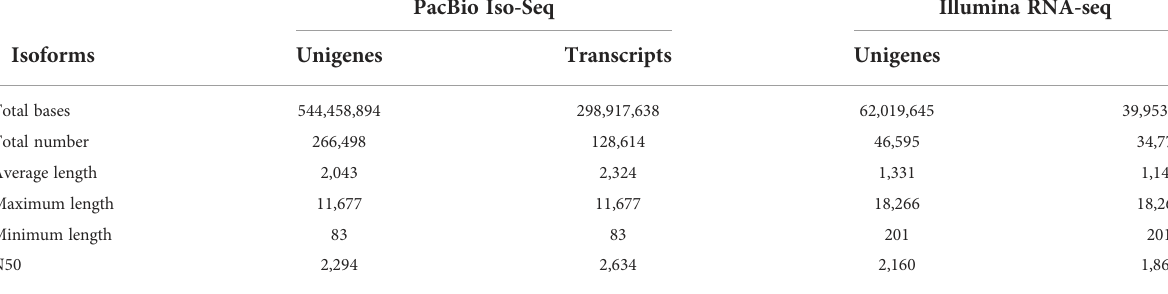
TABLE 3 Summary for the transcriptome of E. sinensis using PacBio Iso-Seq and Illumina